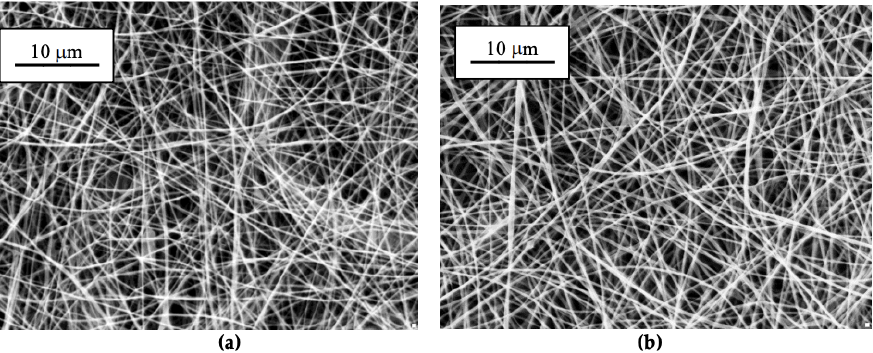
Figure 10. FESEM images of two different morphologies of soy protein concentrate (SPC)/poly ethylene oxide (PEO) nanofibers collected on a V-shaped cardboard substrate two different needle- collector distances; ( a ) 20 cm and ( b ) 15 cm. Reprinted from ref. [54].